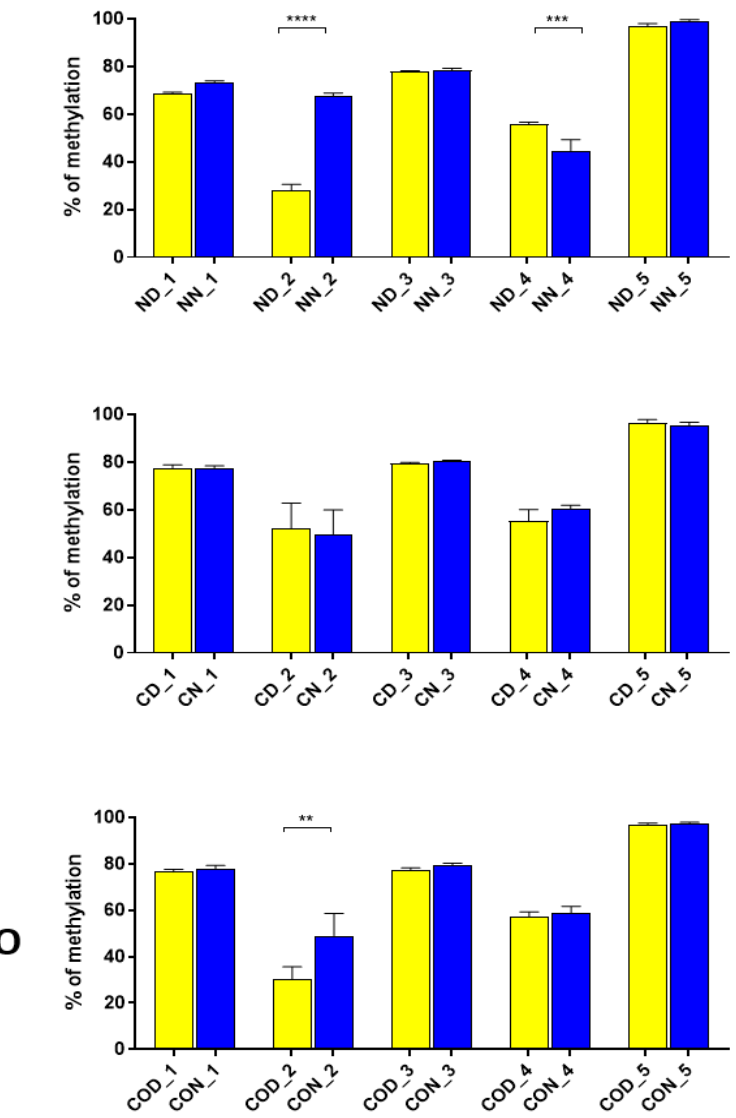
Figure 3. The difference between day (yellow bar) and night (blue bar) methylation levels in the hypothalamus in the normal (N), control (C) and CO-treated groups. The highest methylation level was observed in − 1185– − 1224 bp, where it was on 80–100%. The methylation level was significantly higher at the 2nd and 4th CpG position in hypothalamic DNA samples collected at night in the normal and in 2nd CpG position in the CO-treated group. The bars are represented as mean ± SEM. The asterisks indicate significant differences as follows: **— p < 0.01; ***— p < 0.001; ****— p < 0.0001. At the top of the figure is the examined sequence: original ( top ) and bisulfite converted with highlighted methylation position ( bottom ).